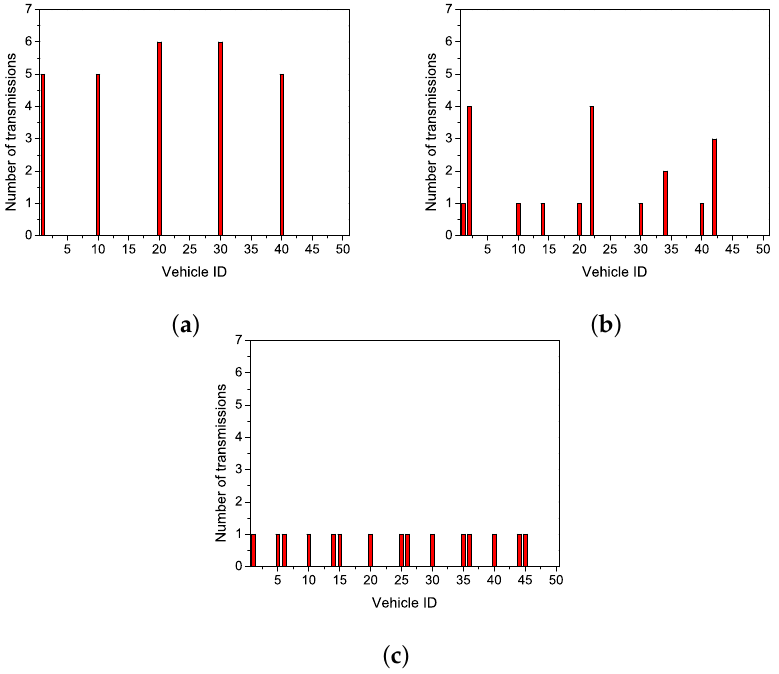
Figure 4. Comparisons of the number of transmissions. ( a ) multichannel TDMA MAC protocol (VeMAC). ( b ) cooperative ad hoc MAC protocol (CAH-MAC). ( c ) OCA-MAC.